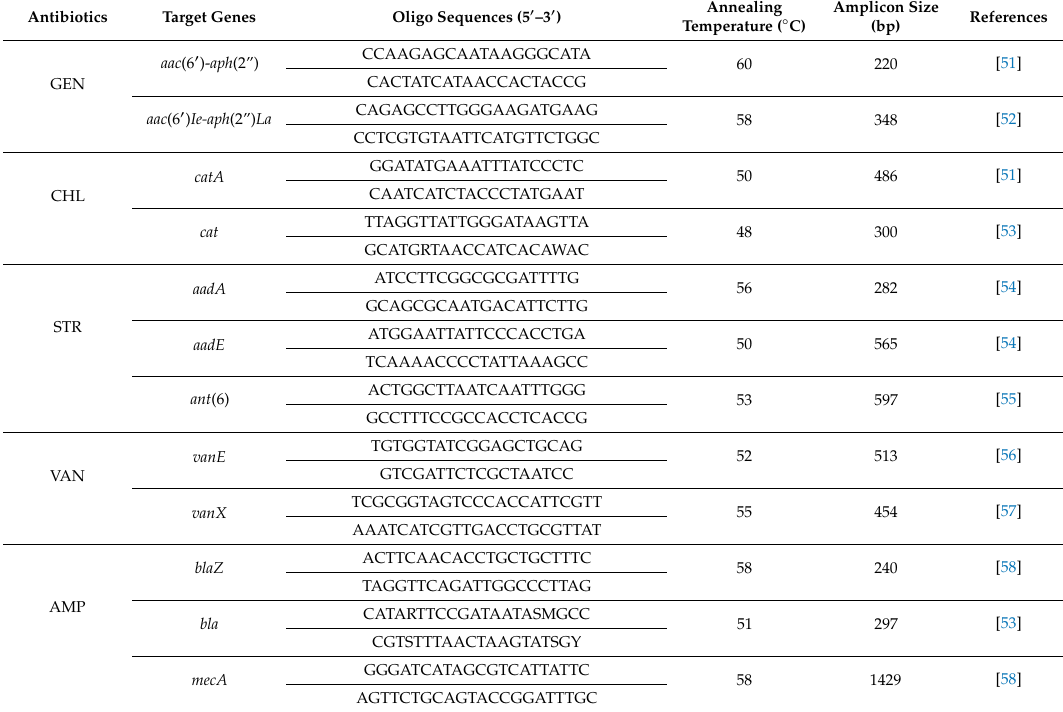
Table 7. Gene-specific primers and conditions for polymerase chain reaction (PCR)